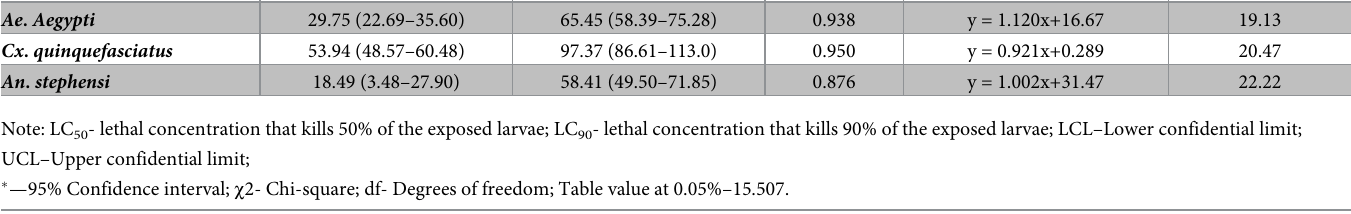
and Beauveria bassiana had larvicidal activity against Ae . aegypti [50, 51]. In the present study the ovicidal, pupicidal and larvicidal activities were compared with the AgNPs synthesized by Bt (Positive control) that showed a good number of mortality in all the observations (S1, S3 and S5 Tables, S1–S4 Figs). The LC and LC values for ovicidal activity were 36.81ppm and 50 90